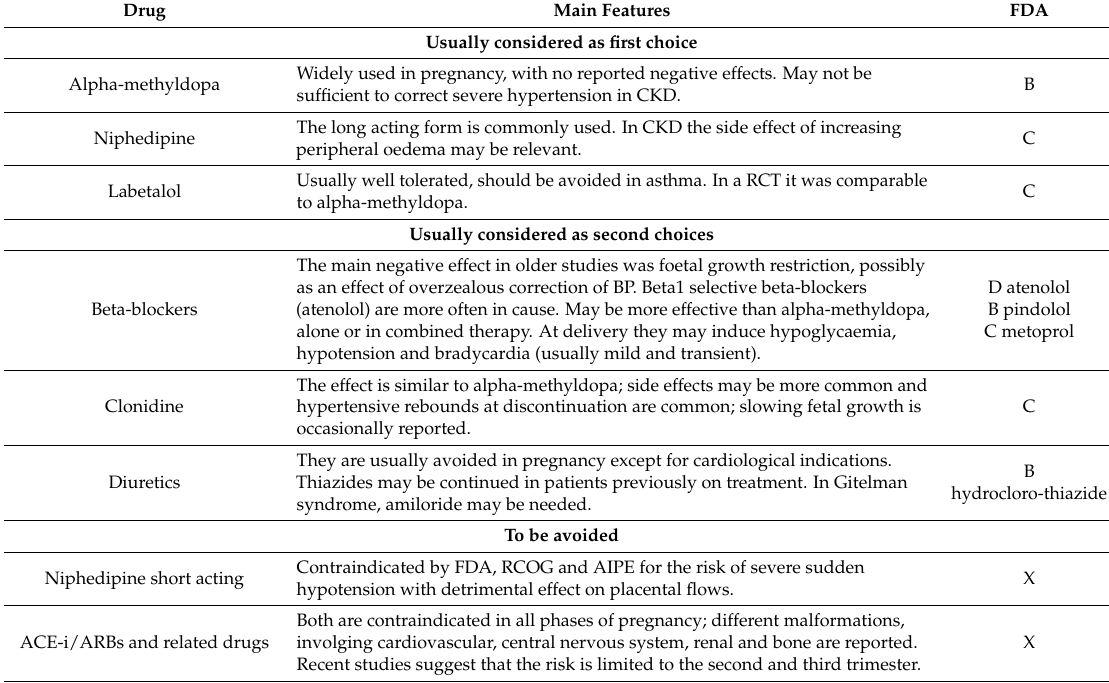
Table A2. Main anti-hypertensive drugs for CKD patients in